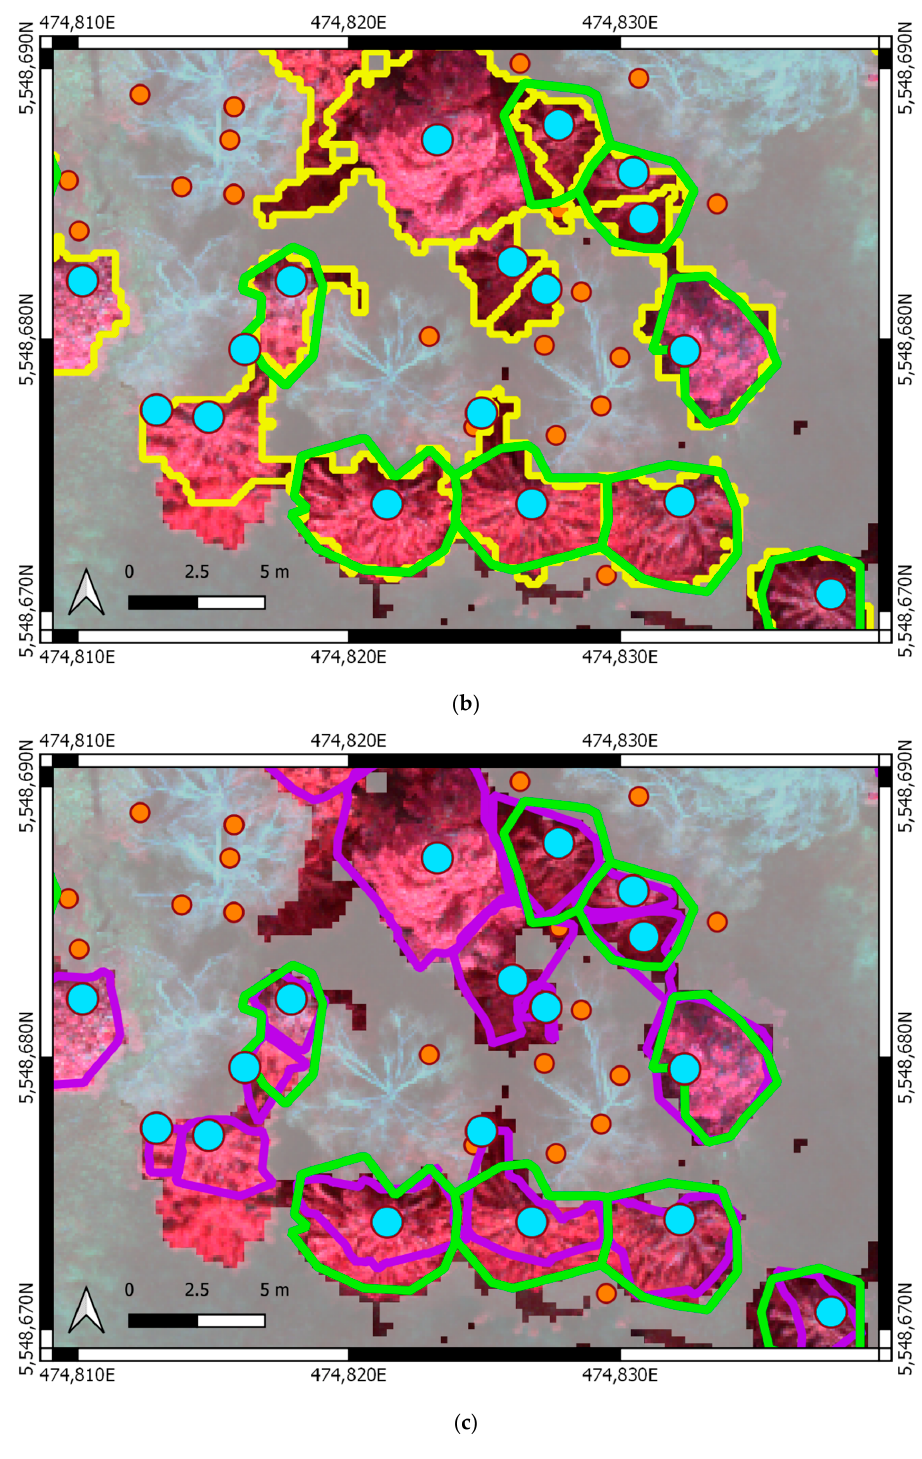
Figure 3. The results of vegetation masks application before the ITCD in the detail: ( a ) The LI segmentation method applied to point cloud directly. Segmented crowns using the ExG mask are highlighted in blue. Segmented crowns using no mask are highlighted in red. Reference crowns are highlighted in green; ( b ) The MCWS segmentation method using seed points. The seed points are segmented in light blue. The identified treetops from PPC with no mask are highlighted in orange. Segmented crowns are highlighted in yellow. Reference crowns are highlighted in green; ( c ) The DAL segmentation method using seed points. The seed used points masked by combi mask in light blue. The identified treetops from PPC with no mask are highlighted in orange. Segmented crowns are highlighted in purple. Reference crowns are highlighted in